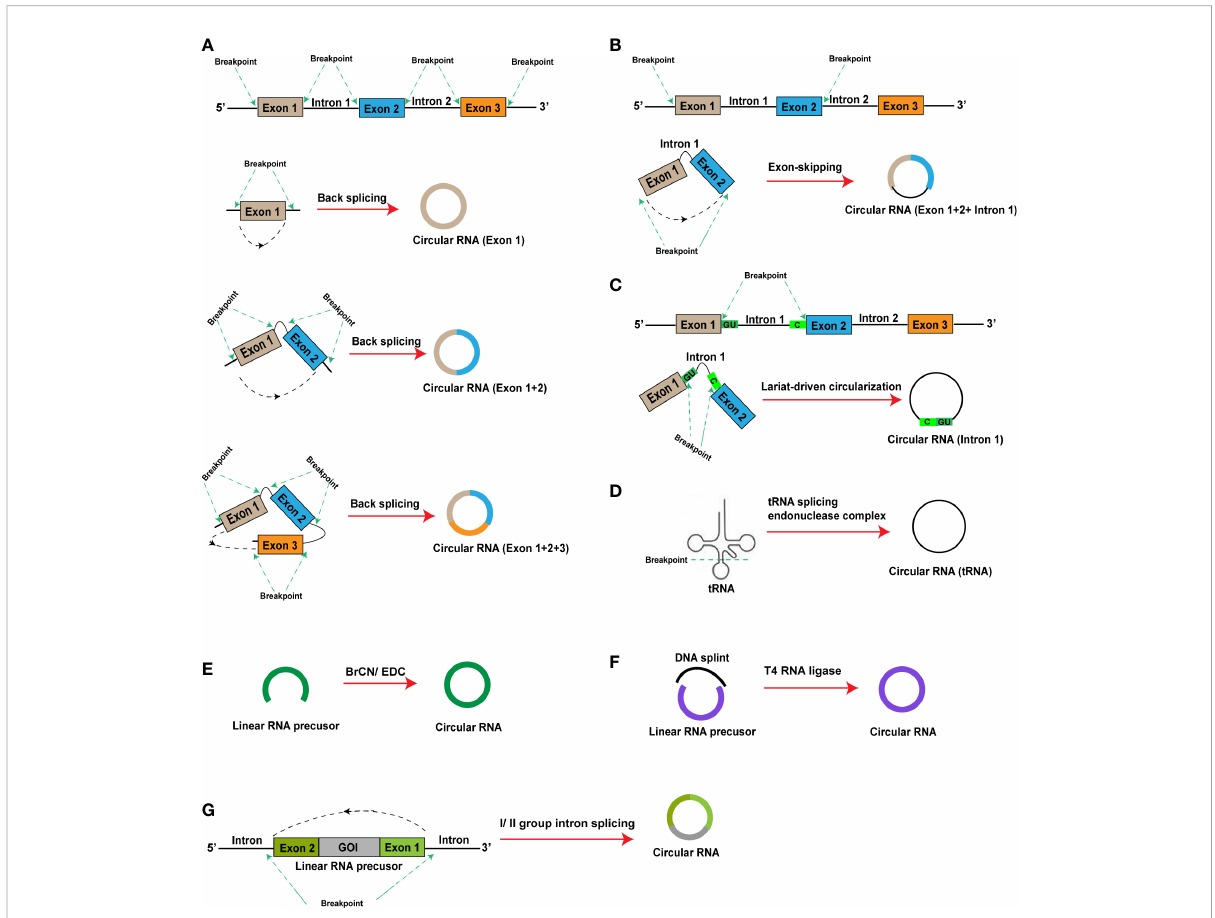
FIGURE 2 In vivo and in vitro (arti fi cial) RNA circularization methods. (A – D) In vivo RNA circularization methods: (A) Exonic circRNA; (B) Exonic-intronic circRNA; (C) Intronic circRNA; (D) tRNA intronic circRNA; (E, F) In vitro (arti fi cial) RNA circularization methods: (E) Chemical synthesis; (F) Ligation by T4 RNA ligase; (G) Intron self-splicing. BrCN, cyanogen bromide; EDC, 1-ethyl-3-(3-dimethylaminopropyl) carbodiimide; GOI, gene of